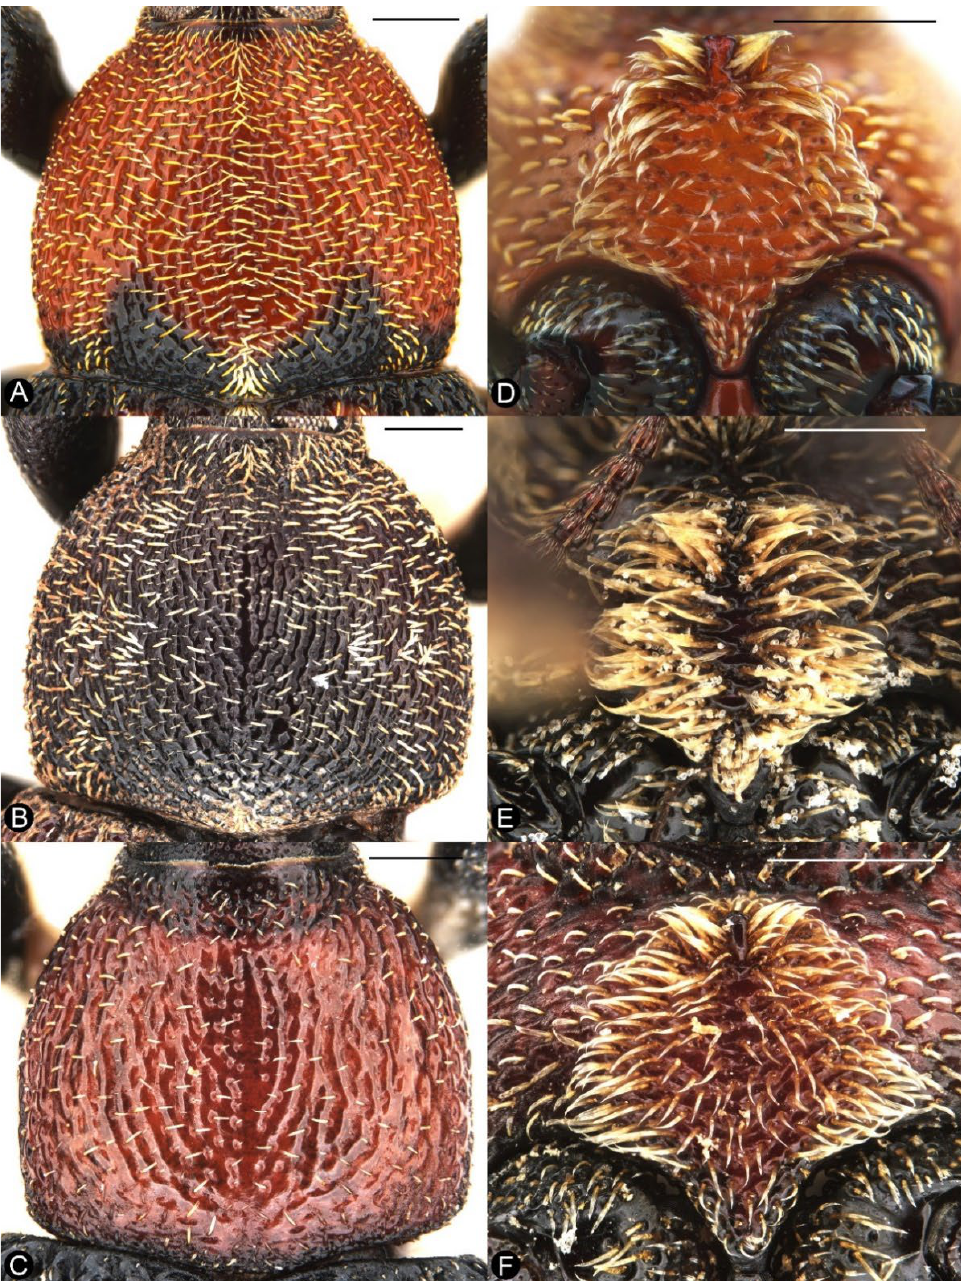
Figure 4. Diagnostic external characters of Miltotranes : ( A ) M. prosternalis , pronotum, dorsal view; ( B ) M. subopacus , ditto; ( C ) M. wilsoni sp. n., ditto; ( D ) M. prosternalis , prosternal elevated, erect-setose process of male; ( E ) M. subopacus , ditto; ( F ) M. wilsoni sp. n., ditto. Scale bars: 0.5 mm.